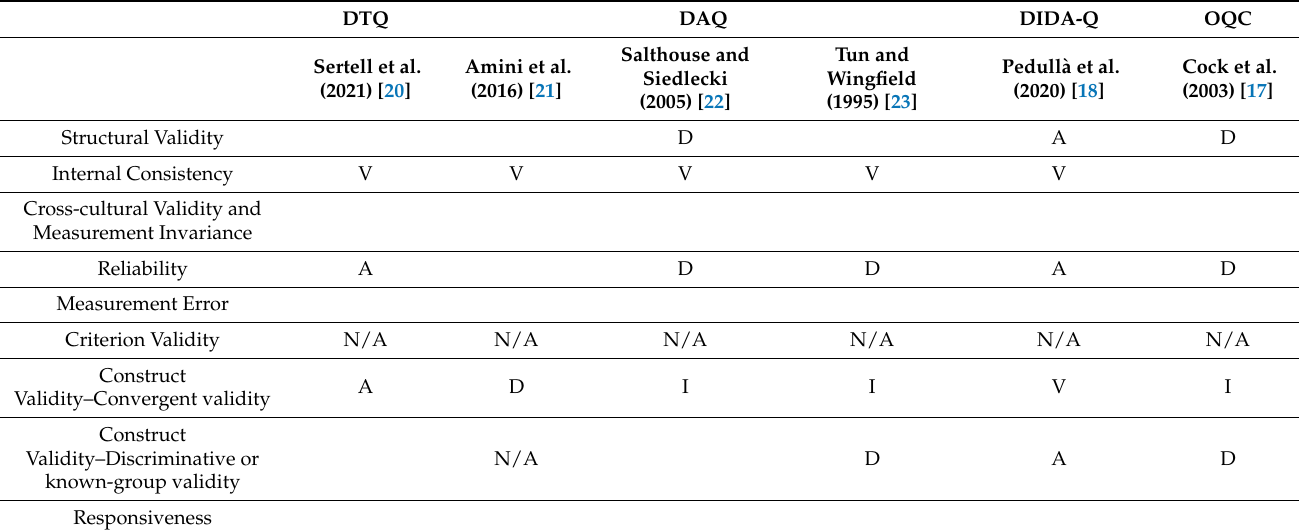
Table 2. Quality of studies on measurement